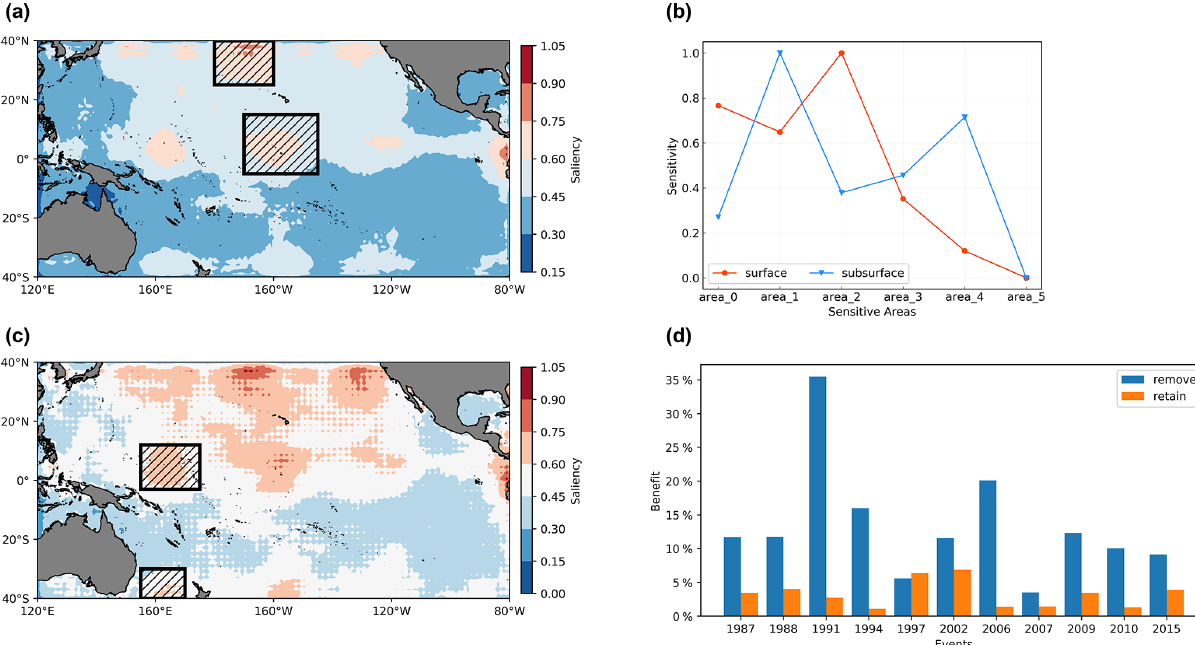
Figure 19. Sensitive areas identification results for ENSO with the saliency map method. Panel (b) compares the sensitivity of the six candidate areas (0–5) for surface (red line) and subsurface (blue line). The first two most sensitive areas are selected as the sensitive areas of targeted observation for ENSO, that is, the area_0 and area_2 for surface and the area_1 and area_4 for subsurface layers, specifically, the hatched areas in (a) (surface) and (c) (subsurface). In order to evaluate the effectiveness of the above identified sensitive areas, (d) compares the benefit of removing the random perturbations in the sensitive areas (blue bars) and removing the random perturbations outside the sensitive areas (orange bars) (that is, retaining the random perturbations in the sensitive areas) for the eight El Niño events and three La Niña events which occurred in the past 30